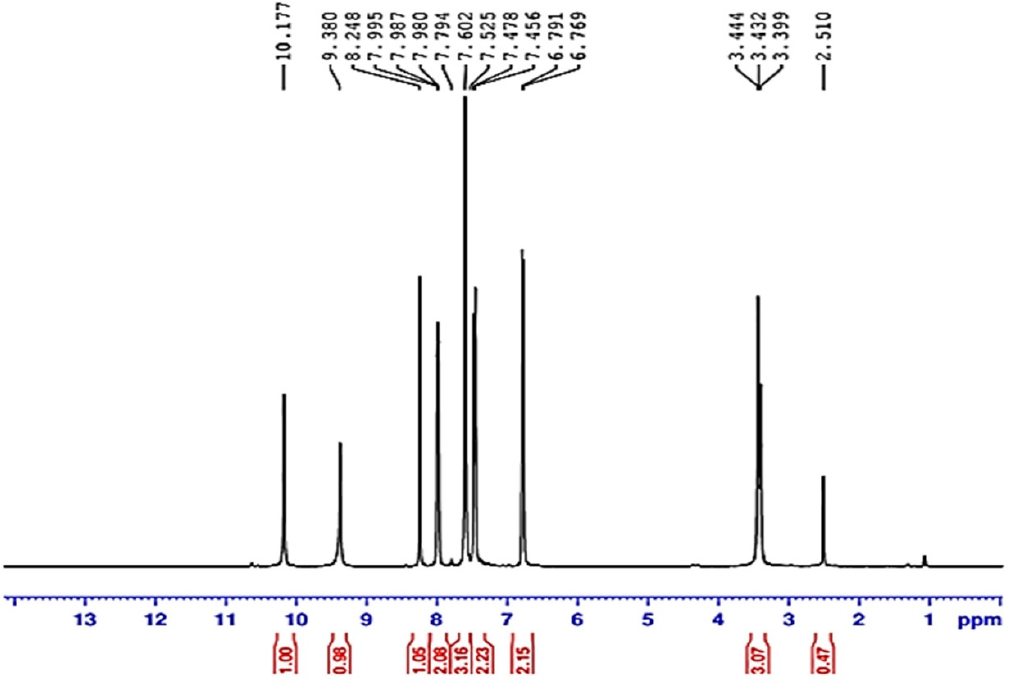
Figure 6. The 1H-NMR spectrum of ACR-3.